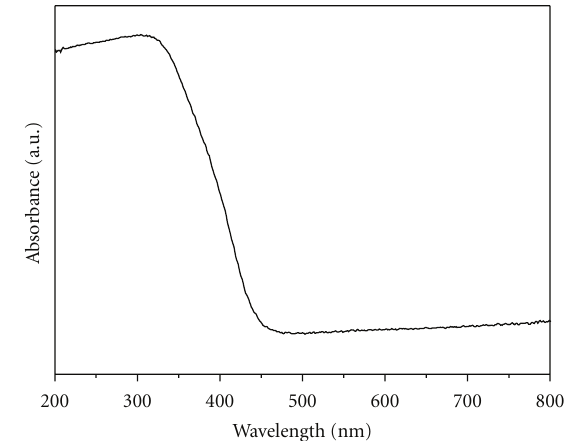
Figure 2: Di ff use reflectance spectrum of as-prepared Bi 2 WO 6 sam-